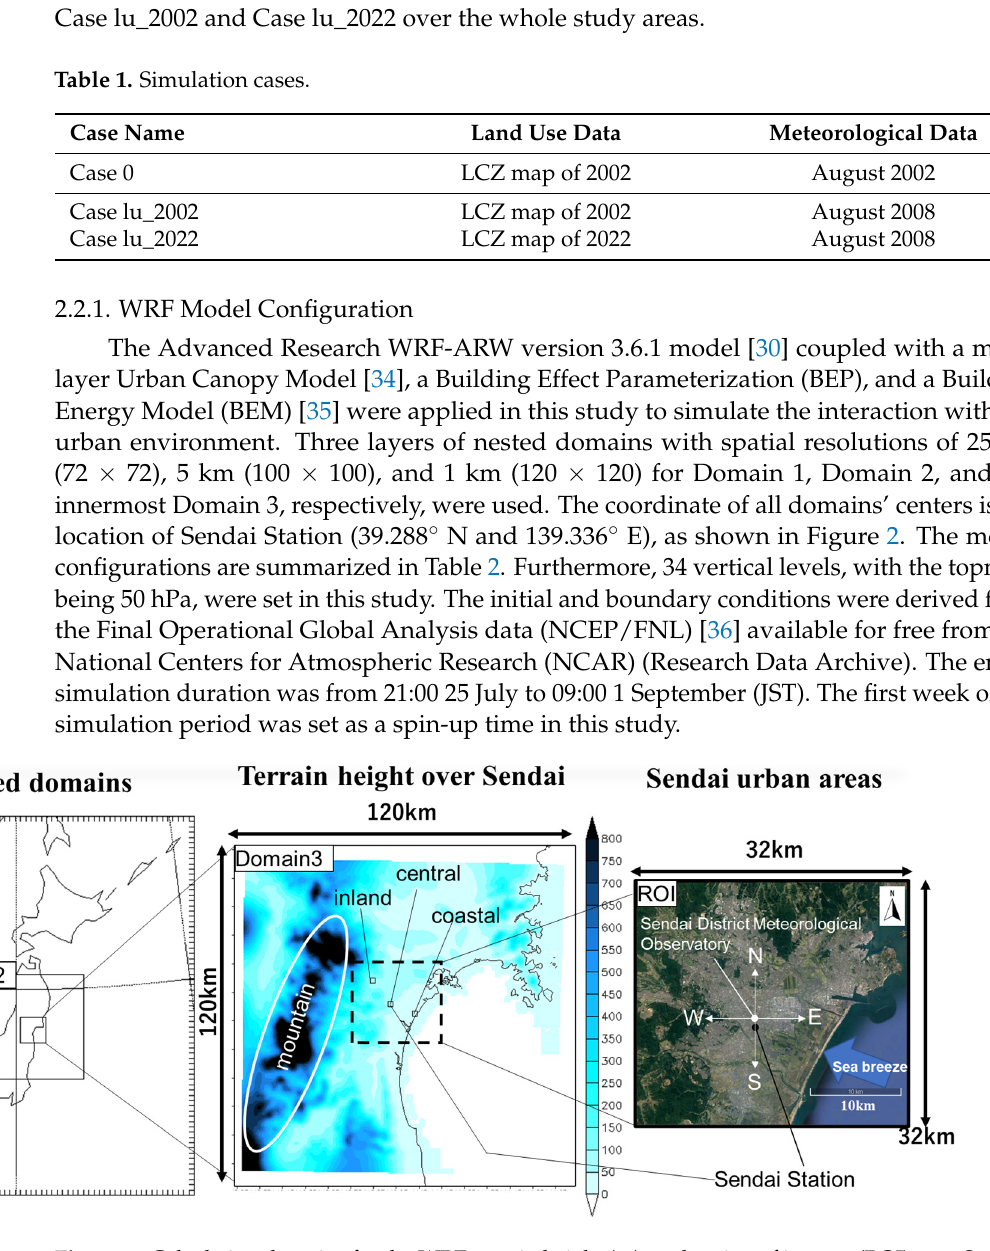
Figure 2. Calculation domains for the WRF, terrain height (m), and region of interest (ROI) over Sendai.